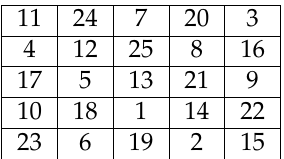
Figure 4. A 5 × 5 magic